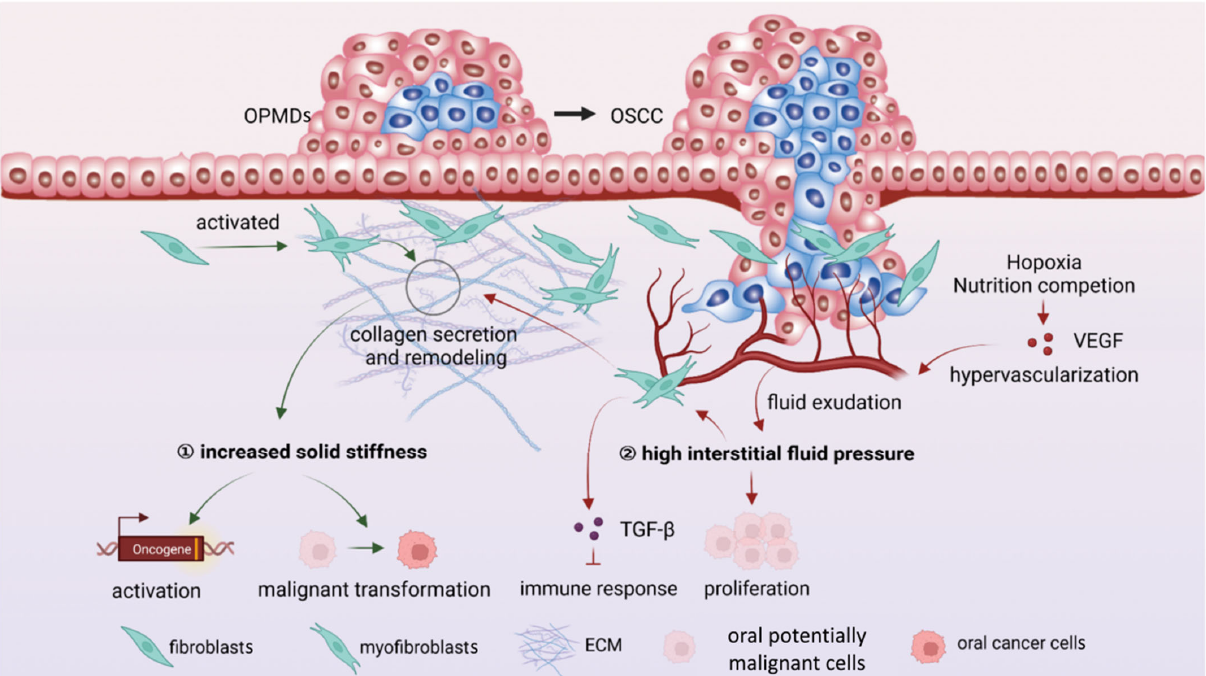
Figure 3. The changes and their carcinogenic roles of the mechanical microenvironment in OPMDs. ① The matrix stiffness gradually increases, promotes oncogene activation, and induces cell malignant transformation. ② The interstitial fluid pressure increases due to the fluid exudation from excessive blood vessels into the ECM and promotes carcinogenesis by inhibiting immune response and promoting cell proliferation. Pointed arrows mean “promote” and blunt ‐ end arrows mean “inhibit”. VEGF, vascular endothelial growth factor; ECM, extracellular matrix.